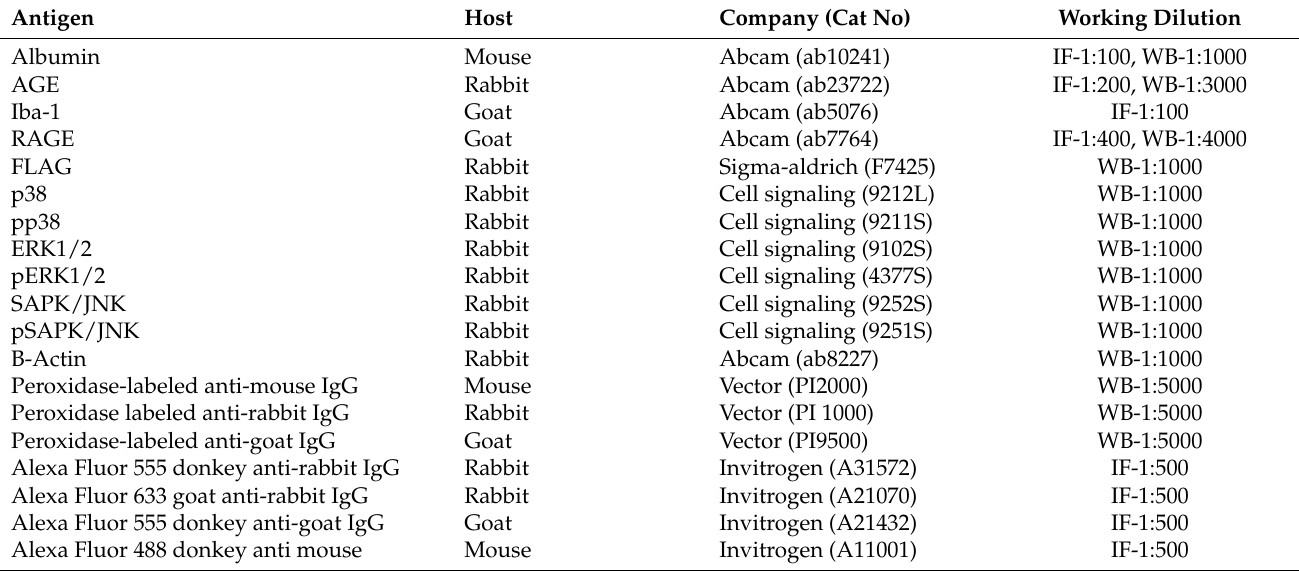
Table 1. List of antibodies used in this